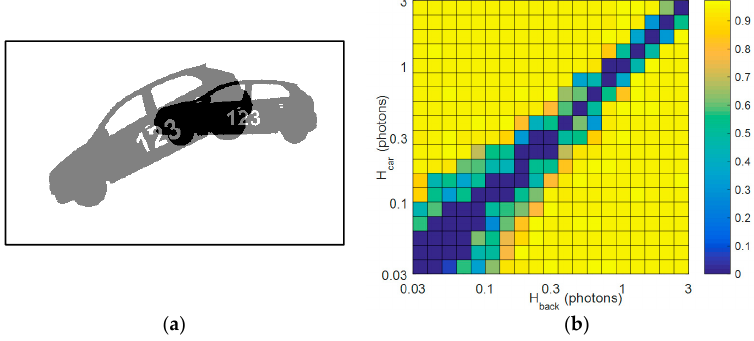
Figure 5. Summarized results from synthetic data set: ( a ) Two-dimensional ( 2D) car model (mask) used to generate data set. The car moves along a circular arc, with an angle to the vertical of 0.002 i 2 + 0.2 i and a radius of r = 250 jots (where i is the index of the bit-plane), and grows in size at a rate of 0.5% per bit-plane. Shown are the initial ( i = 1) and final ( i = 72) positions of the car; ( b ) Heat map of the 2D correlation coefficient R between the reconstructed and still car. The coefficient R is calculated by taking the noise-free image sequence (as in panel a), and calculating the correlation between the image of the car (at i = 1), and the sum of the re-aligned images ( i = 1, ..., 72), based on the trajectory extracted from the synthesized (i.e., randomized with photon noise) bit-plane sequence. Test cases where tracking was not obtained are indicated by R = 0. The tracking-reconstruction scheme was run with the following parameters: { N x , N y , N t } = {8, 8, 8} to create the test frames, d = 1 for producing the difference frames.